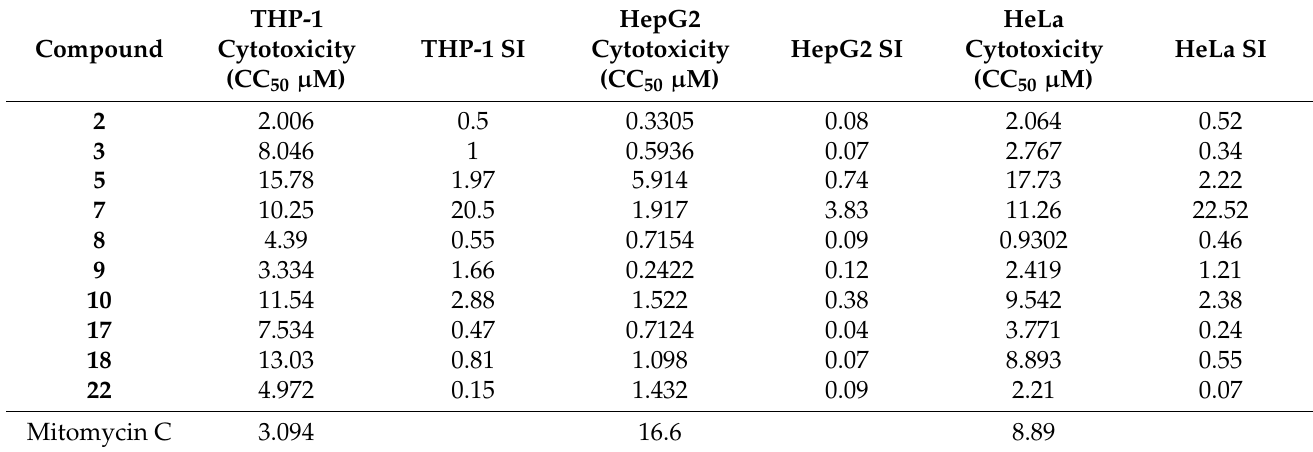
Table 6. Cytotoxicity results and calculated SI for the tested compounds on THP-1, HepG2, and HeLa cell lines.